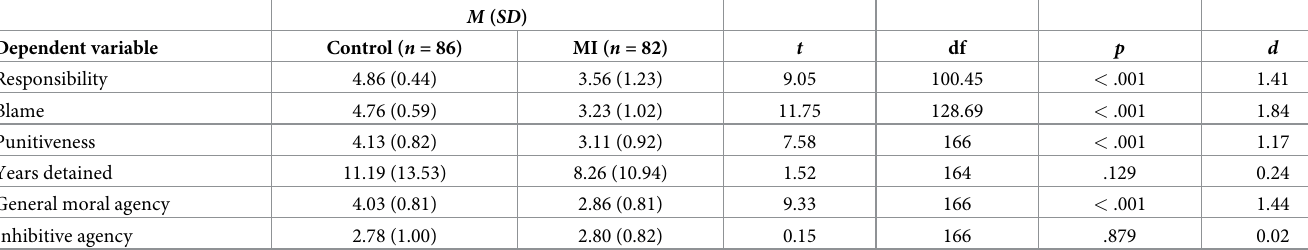
Table 1. Descriptive and t-test statistics for dependent variables at trial (Study 1).